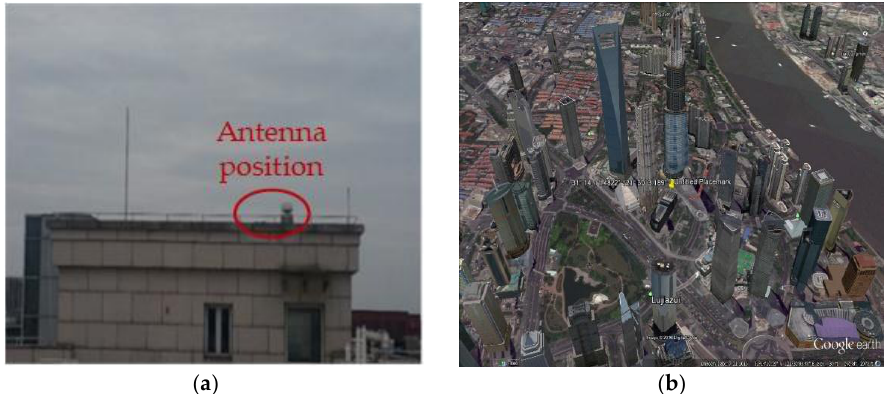
Figure 3. GNSS antenna position ( a ) open sky (rooftop) ( b ) urban canyon (downtown Shanghai).